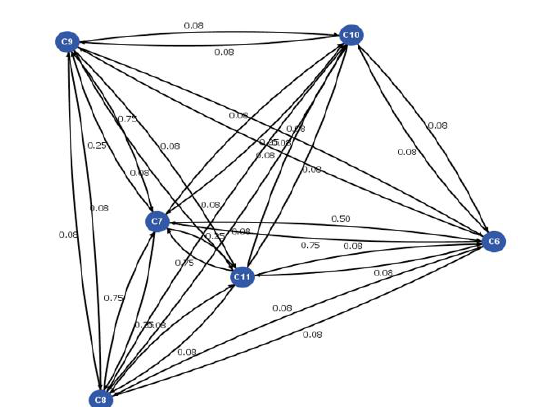
Fig. 9. Graphical representation of S&E factors of